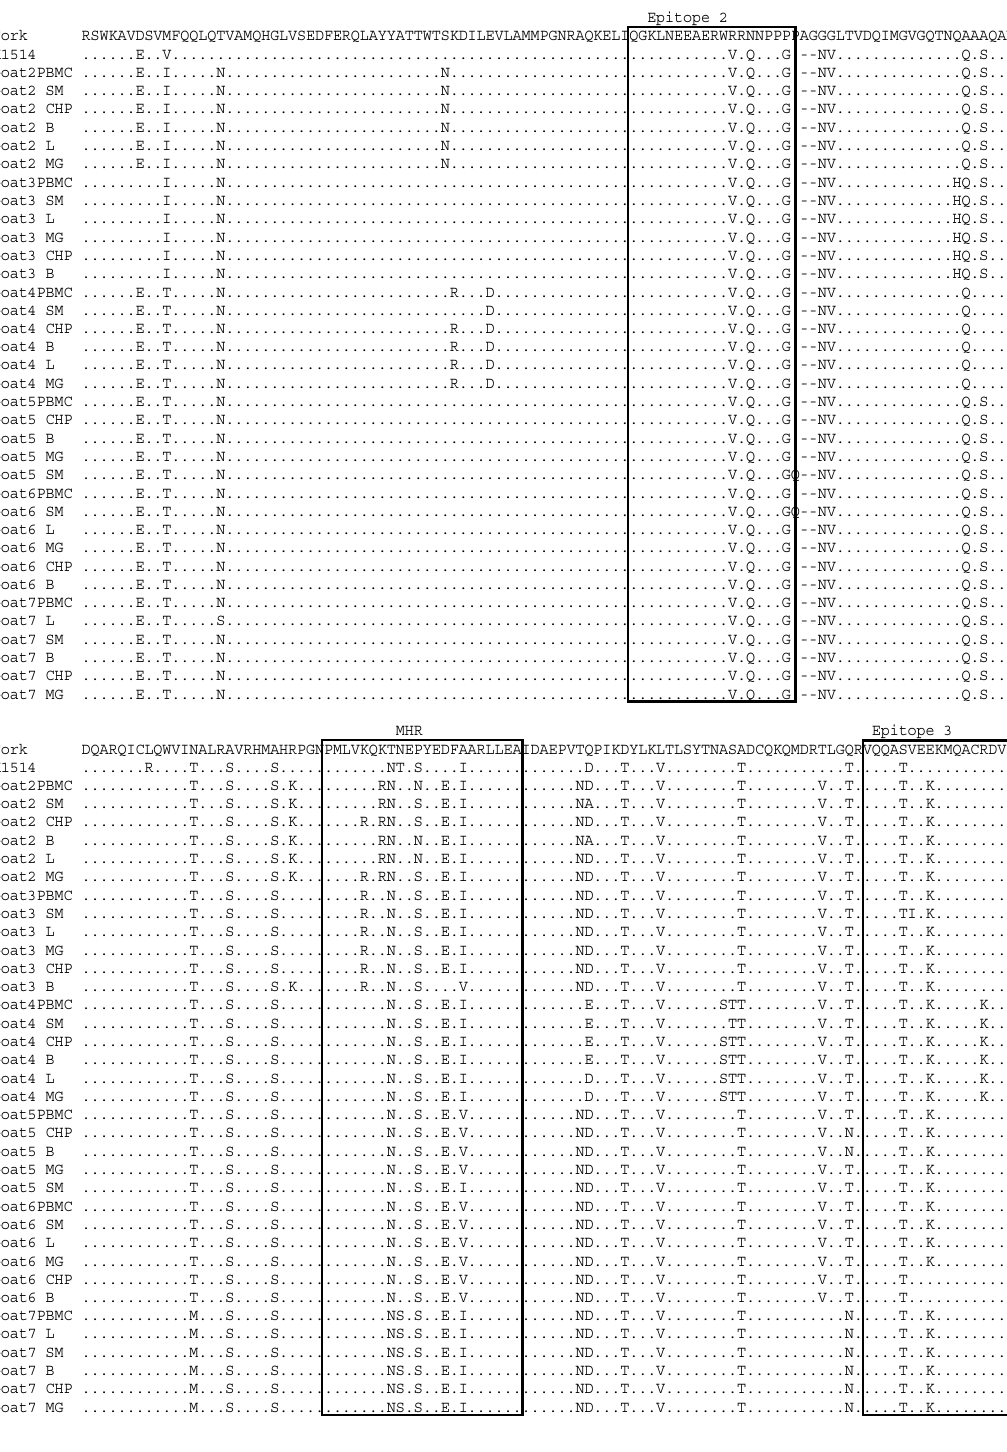
Figure 4. Alignment (MUSCLE) of deduced amino acid sequences of the gag -p25 capsid protein of SRLVs obtained in this study and K1514 (GenBank accession number M60609) and Cork (GenBank accession number M33677) reference strains, which are MVV (group A) and CAEV (group B) pro- totype strains, respectively. Identical residues are indicated by dots (.). Two immunodominant epitopes and the major homology region (MHR) are within squares. PBMC—Peripheral blood mononuclear cells, L—Lung, SM—Synovial membrane, B—Brain, CHP—Choroid plexus, MG— Mammary gland.